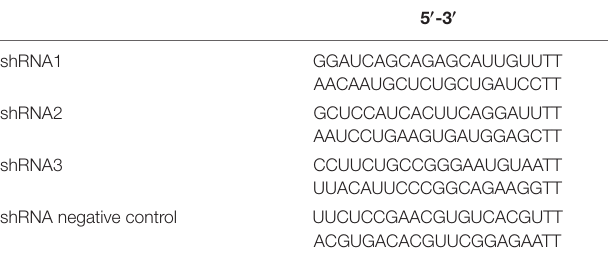
TABLE 1 | Small interfering RNA sequences to Parkin and negative